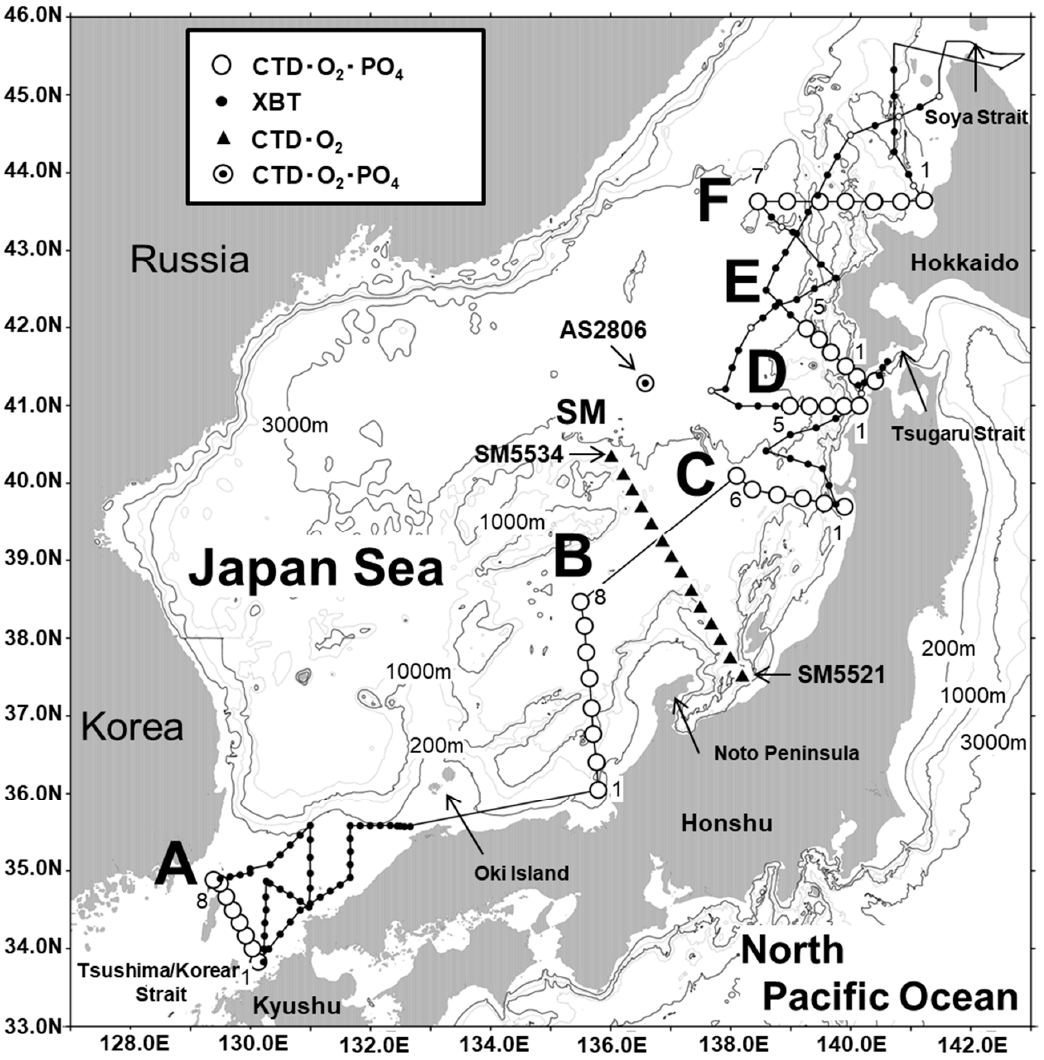
Figure 1. Bottom topography and hydrographic stations used in the study.